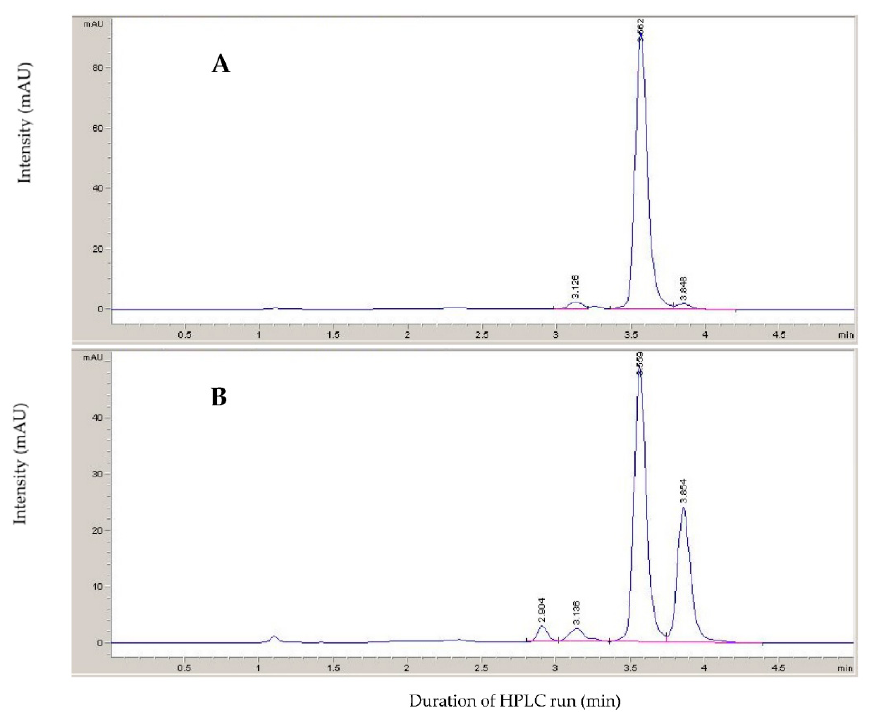
Figure 2. Chromatograms (at 285 nm; isocratic reversed-phase HPLC with 40% acetonitrile containing 0.02% triethylamine) of: ( A ) xanthoxal (dissolved in acetonitrile) produced by permanganate oxidation of violaxanthin; ( B ) the mixture of geometric isomers obtained after irradiation with a Wood